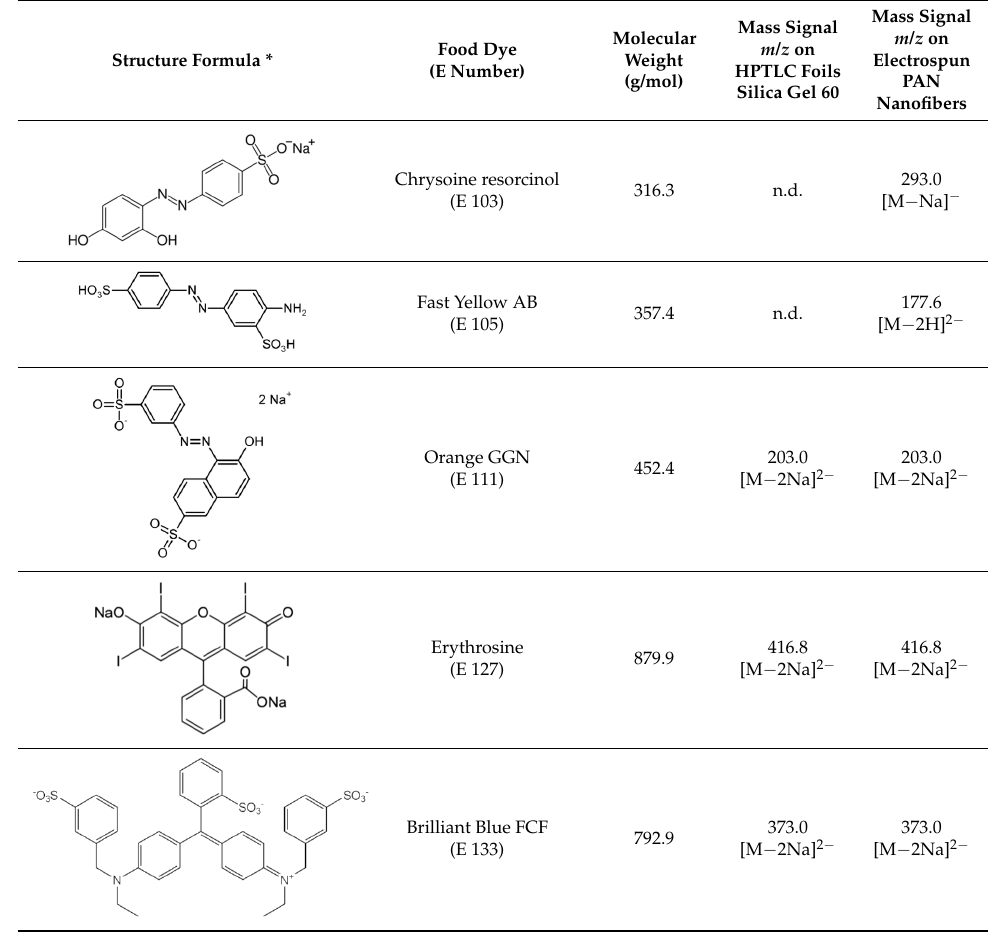
Table 2. Structure formulae of the food dyes, their molecular weights, and mass signals on HPTLC foils silica gel 60 versus electrospun PAN nanofiber phases.